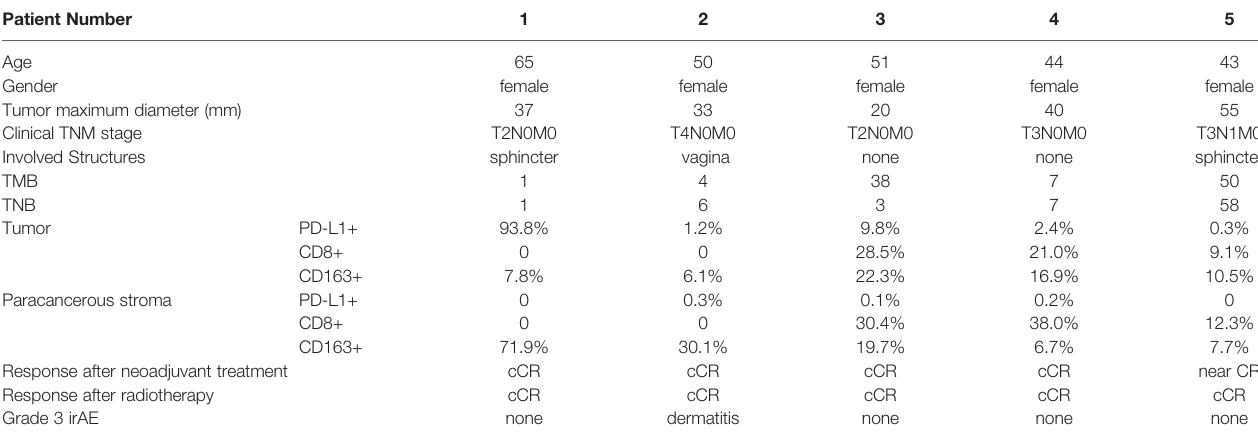
TABLE 1 | Clinical information and biomarker of the 5 locally advanced ACSCC